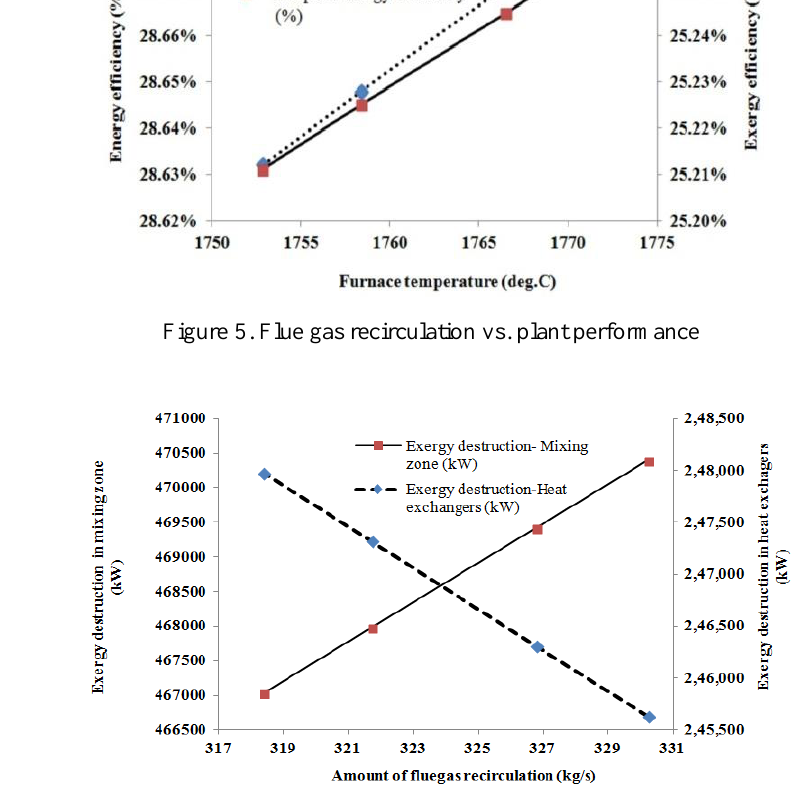
Figure 6. Flue gas recirculation vs. combustor